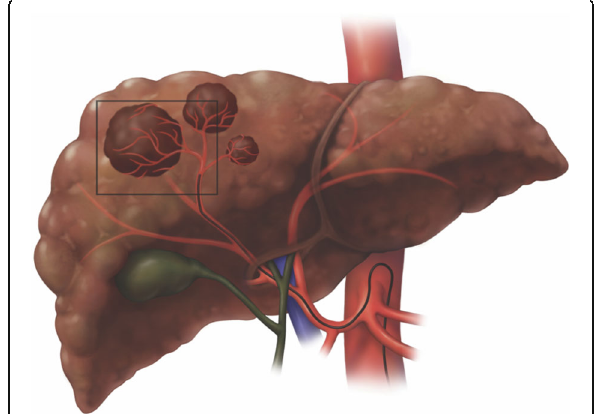
Fig. 17 Transcatheter therapy. Tumor arterial blood supply is